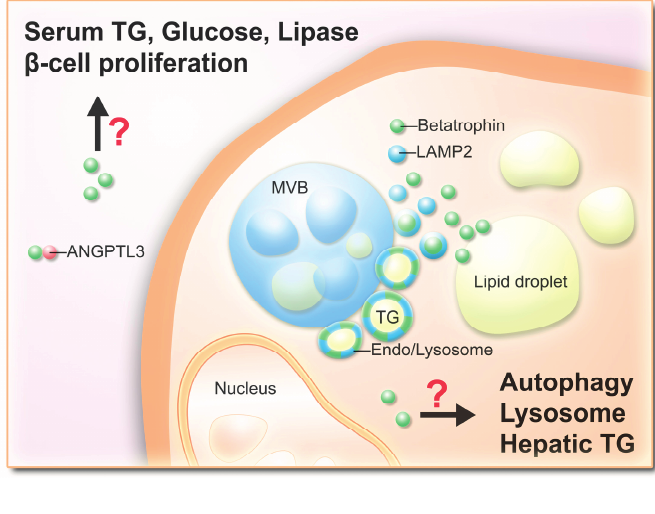
Figure 3. Schematic representation of hypothetic betatrophin functions. Secreted betatrophin interacts with ANGPTL3 and/or modulates β -cell proliferation, serum TG levels, serum glucose levels and lipase activity. Intracellular betatrophin associated with lipid droplets and endosome/lysosome vesicles which may serve as a lipoprotein and activate